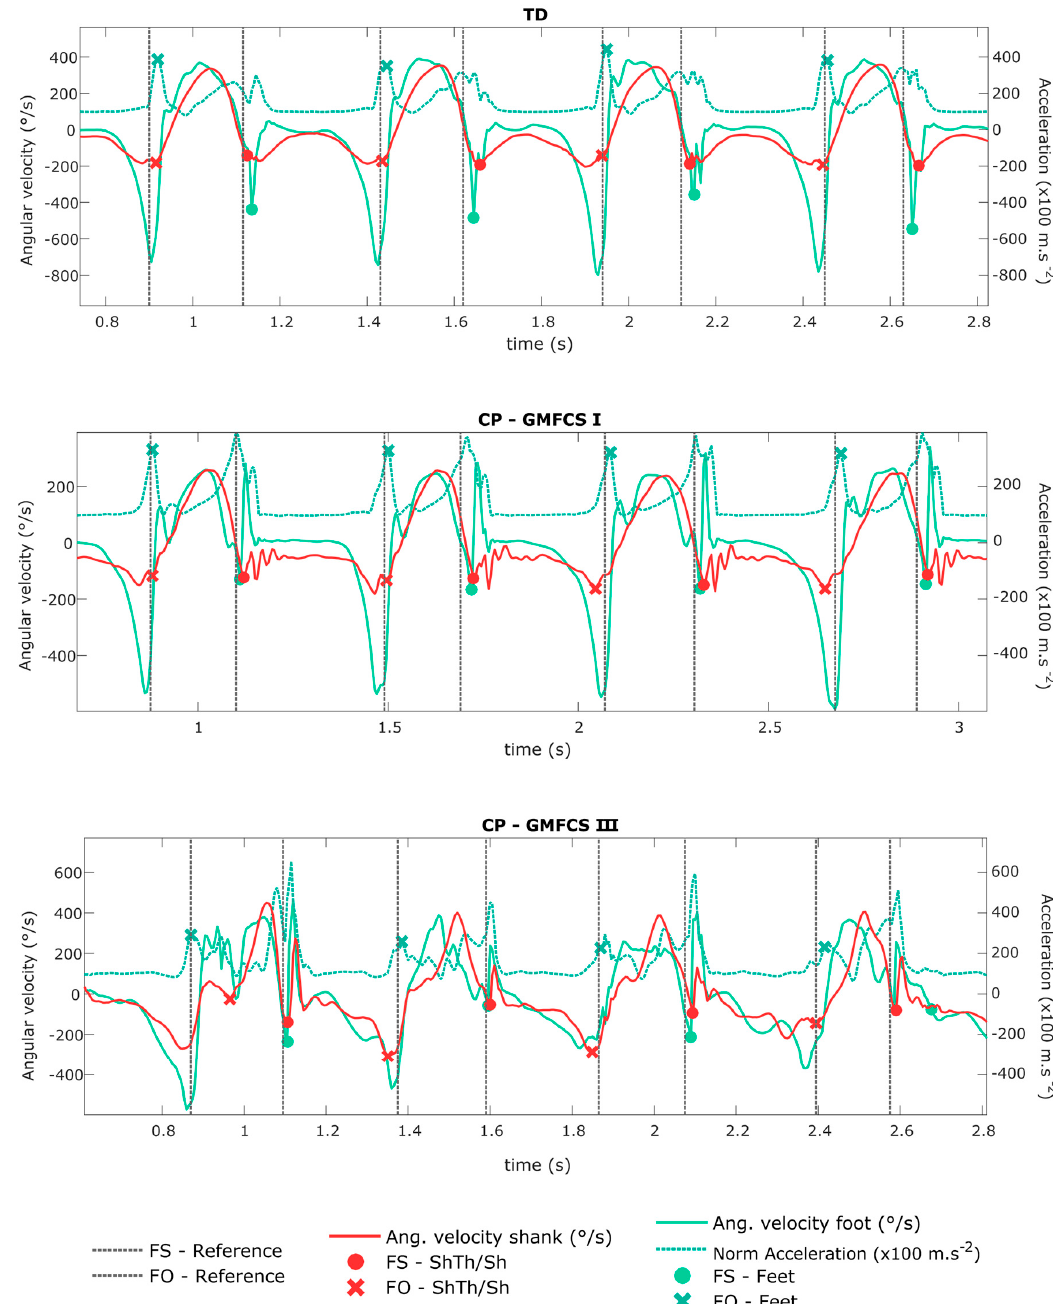
Figure 2. Shank angular velocity and foot angular velocity and norm of acceleration signals (measured by the wearable configurations ShTh/Sh and Feet). The gait events (FS and FO) detected by the wearable configurations are shown by the symbols on the corresponding signals. The vertical lines define FS and FO detected by the reference. Four strides are represented for each example, corresponding to a typically developing (TD) child, a child with CP-GMFCS I, and a child with CP-GMFCS III.